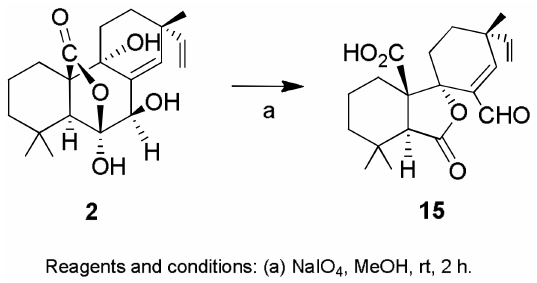
Scheme 2. The structures of sphaeropsidin B ( 2 ) and its derivative ( 15 ).